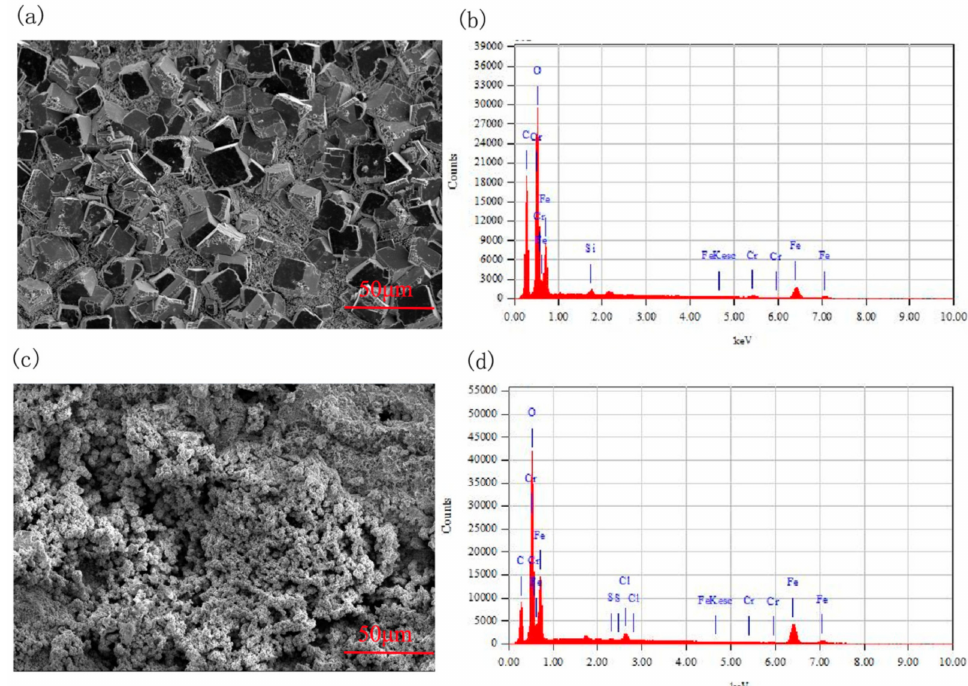
Figure 6. SEM and elemental analysis of erosion-corrosion products in CO 2 and CO 2 –O 2 environments ( a ) P CO2 : 2.5 MPa, surface morphology, ( b ) P CO2 : 2.5 MPa, elemental analysis, ( c ) P CO2 : 2.5 MPa, P O2 :